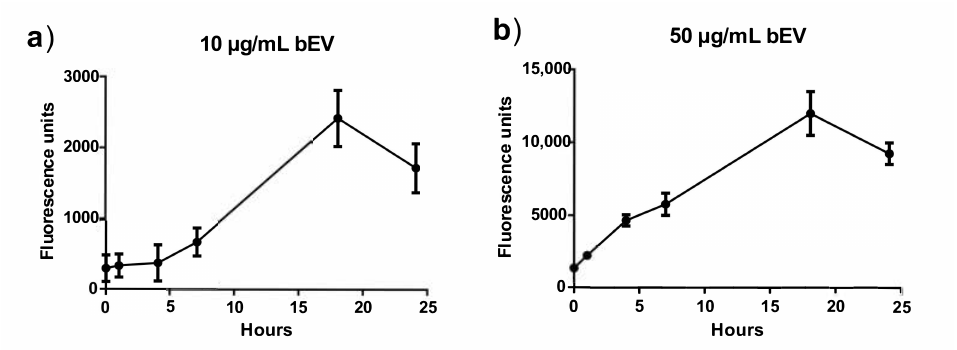
Figure 2. Bovine extracellular vesicles uptake in RAW264.7 cells. To detect bEV uptake, RAW264.7 cells incubated with either ( a ) 10 µ g/mL or ( b ) 50 µ g/mL of fluorescently labelled bEVs for 1, 4, 7, 18, or 24 h. Afterwards, the fluorescence of the resulting cell lysate was quantified. The values are shown as mean ± SD. Two independent experiments were performed in triplicates. Background fluorescence from the lysis buffer was subtracted from the results. See Table 1 for sample